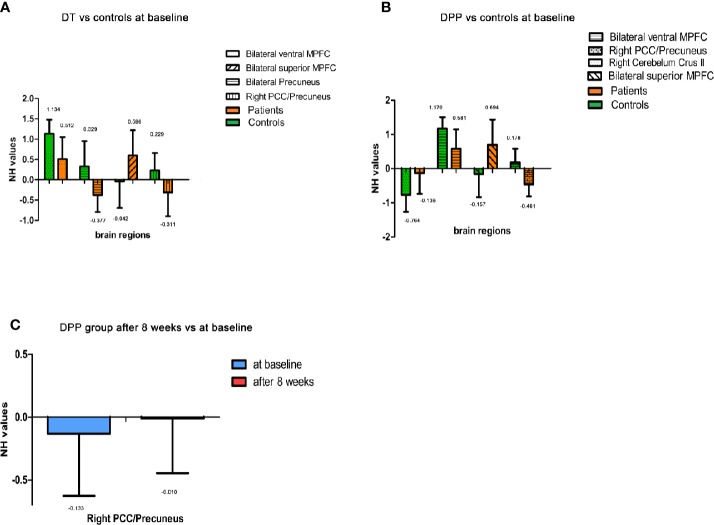
Imaging results across different time points. Values above histogram bars represent related group means. Bars represent related SD. (A) The NH values of brain regions across patients in the DT group and controls at baseline. (B) The NH values of brain regions across patients in the DPP group and controls at baseline. (C) The NH values of brain regions in the DPP group from baseline to 8 weeks.